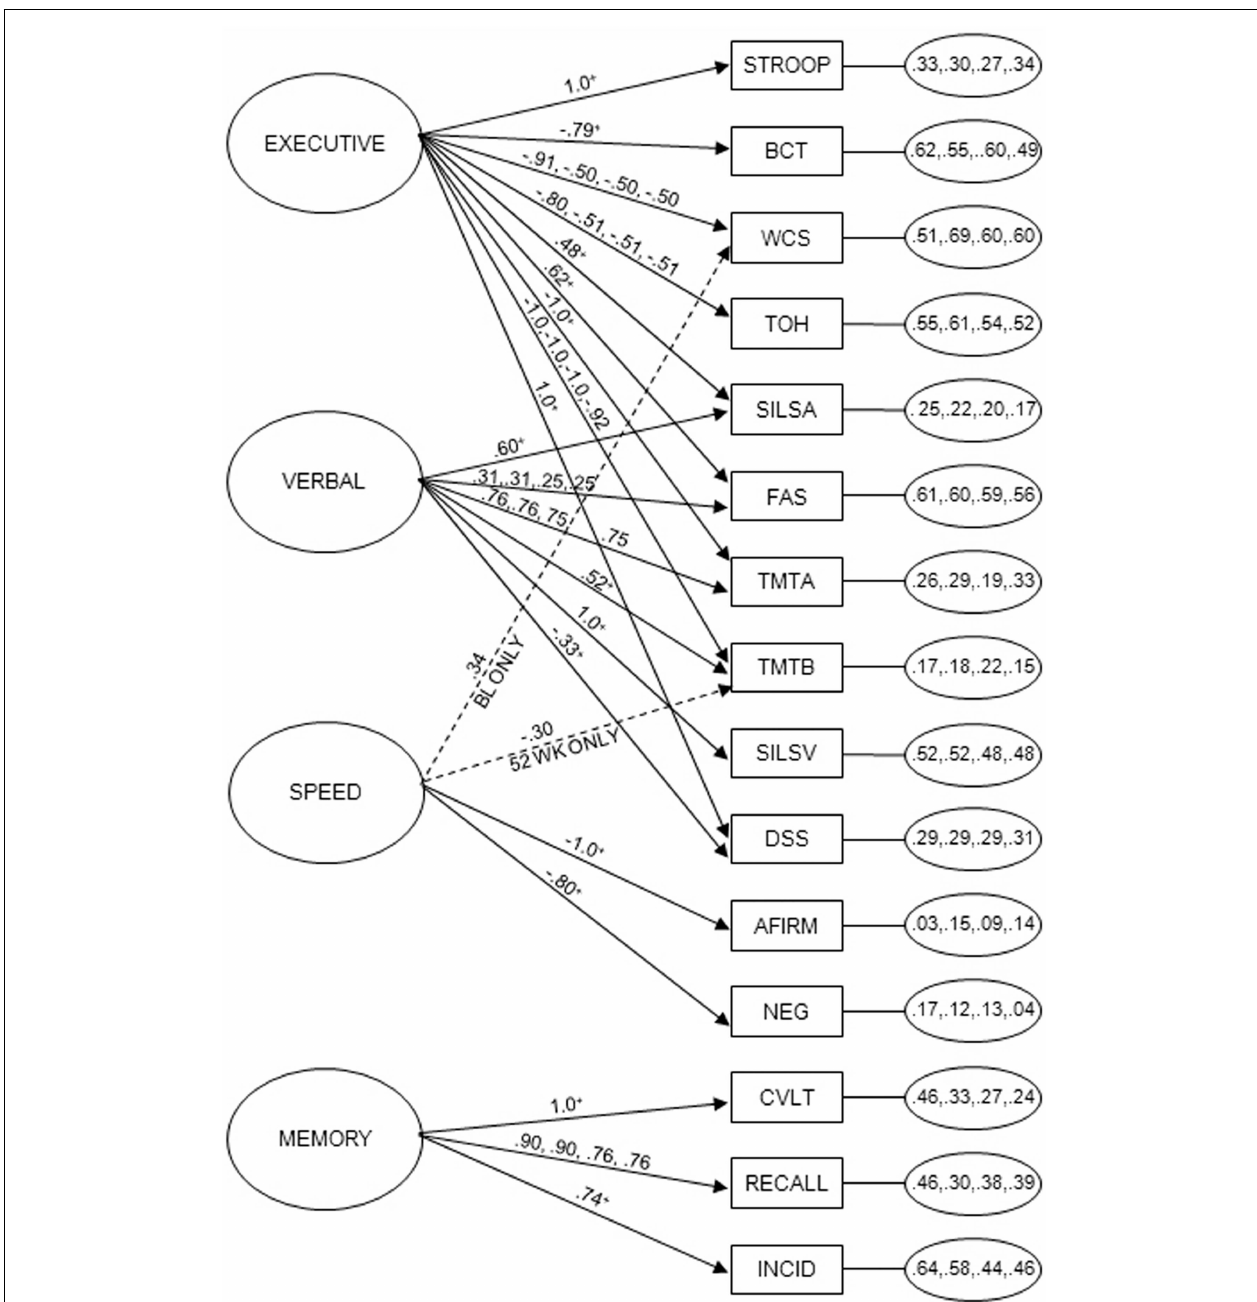
CaliforniaVerbal Learning (CVLT), Product Recall (RECALL). Arrows extending from latent means to indicators show factor loadings at the four test times. With respect to invariance of factor loadings, of the potential 88 unique loadings (22 loadings over 4 test times), 56 were constrained to identity across 4 test times, 12 were constrained to identity across 3 test times, and 12 were constrained to identity across 2 test times without diminishing model fit.There were no violations of pattern invariance for executive, verbal, and memory factors. For speed factor, there was one unique loading at treatment entry and 1 at 52weeks. + Loadings constrained across all four test times; A : loadings constrained across 6, 26, and 52weeks; B loadings constrained across treatment entry and the 6- and 26-week test times; C loadings constrained between treatment entry and the 6-week test time as well as between the 26- and 52-week test